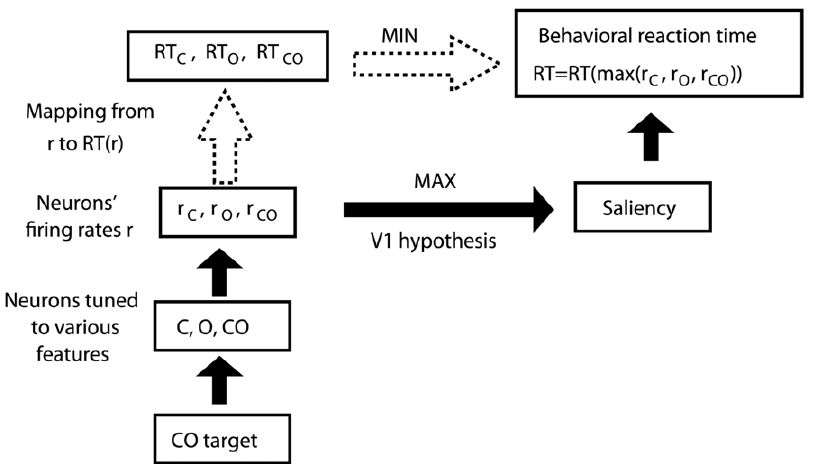
Figure 3. A schematic of the relationship between V1 responses and search RTs. In this example, a CO target activates three types of V1 neurons, tuned to C, O, and CO respectively. Their responses, r C , r O , and r CO , are influenced by intra-cortical mechanisms in V1. Their maximum r max ~ max( r C , r O , r CO ) determines the target’s saliency. Thus the behavioral RT is a function of r max (with distractor responses normalized to 1), through a monotonically decreasing mapping RT ( r max ) determined by the brain mechanisms for saliency read-out and ocular-motor functions. Equivalently, the behavioral RT is min( RT C , RT O , RT CO ) , as the result of a race between the racers C, O, and CO, whose RTs are, respectively, RT C ~ RT ( r C ) , RT O ~ RT ( r O ) , and RT CO ~ RT ( r CO ) .